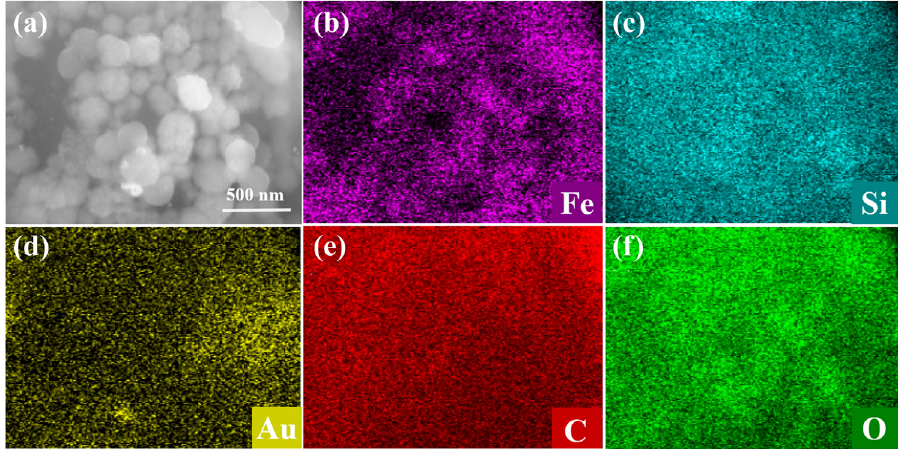
Figure A3: ( a ) SEM image of FSA - MIPs, and elemental mappings of ( b ) Fe, ( c ) Si, ( d ) Au, ( e ) C, and ( f )